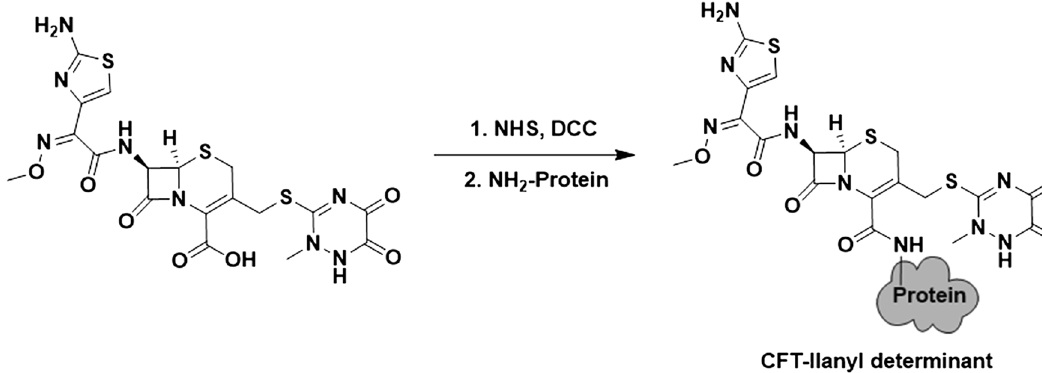
Figure 3. Conjugation of protein CFT -llanyl determinant.